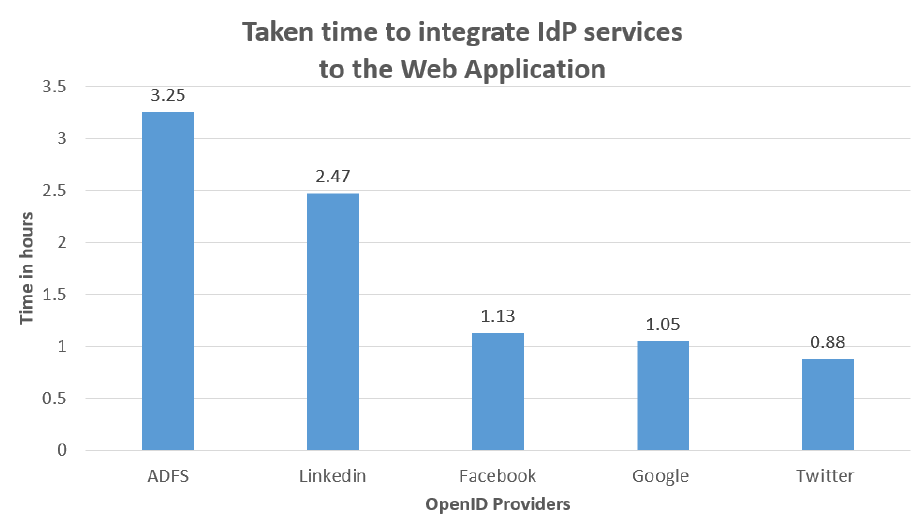
Figure 7. Time taken to integrate IdP services to the Web application.